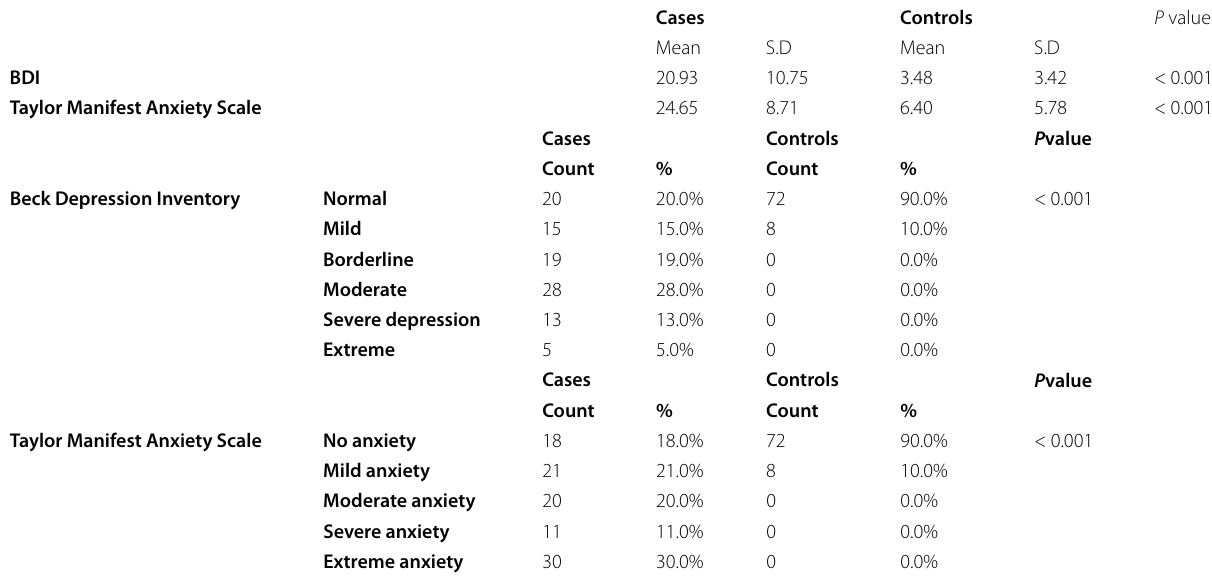
Table 3 Depression and anxiety scores among cases and control